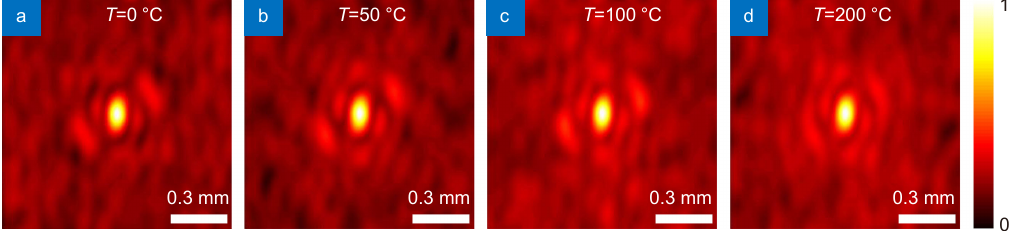
Fig. 5 | Experimental results of the modulus of the DOC | μ | in the focal plane at different temperatures of the HP . The strength factor of the CP is u =−60 mm −2 . T =0 °C stands for the free space case.